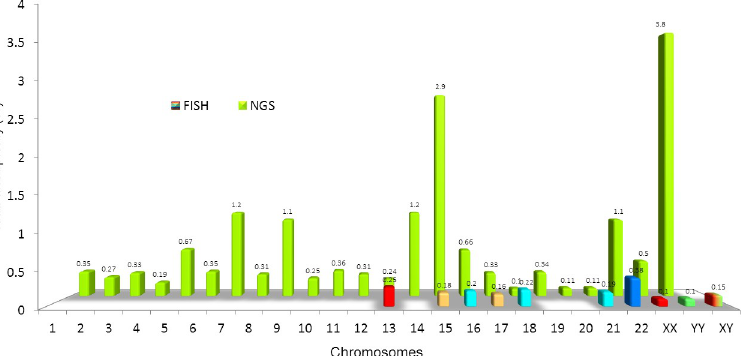
Fig 3. Assessment of sperm aneuploidy for each chromosome by two different methods. In the first row, the minute multicolor columns indicate the chromosomal defects assessed by FISH on 9 chromosomes. In contrast, the green histogram represents whole genome molecular karyotyping by NGS. This technique allows for a more accurate and comprehensive assessment of all chromosomes to detect sperm aneuploidy.